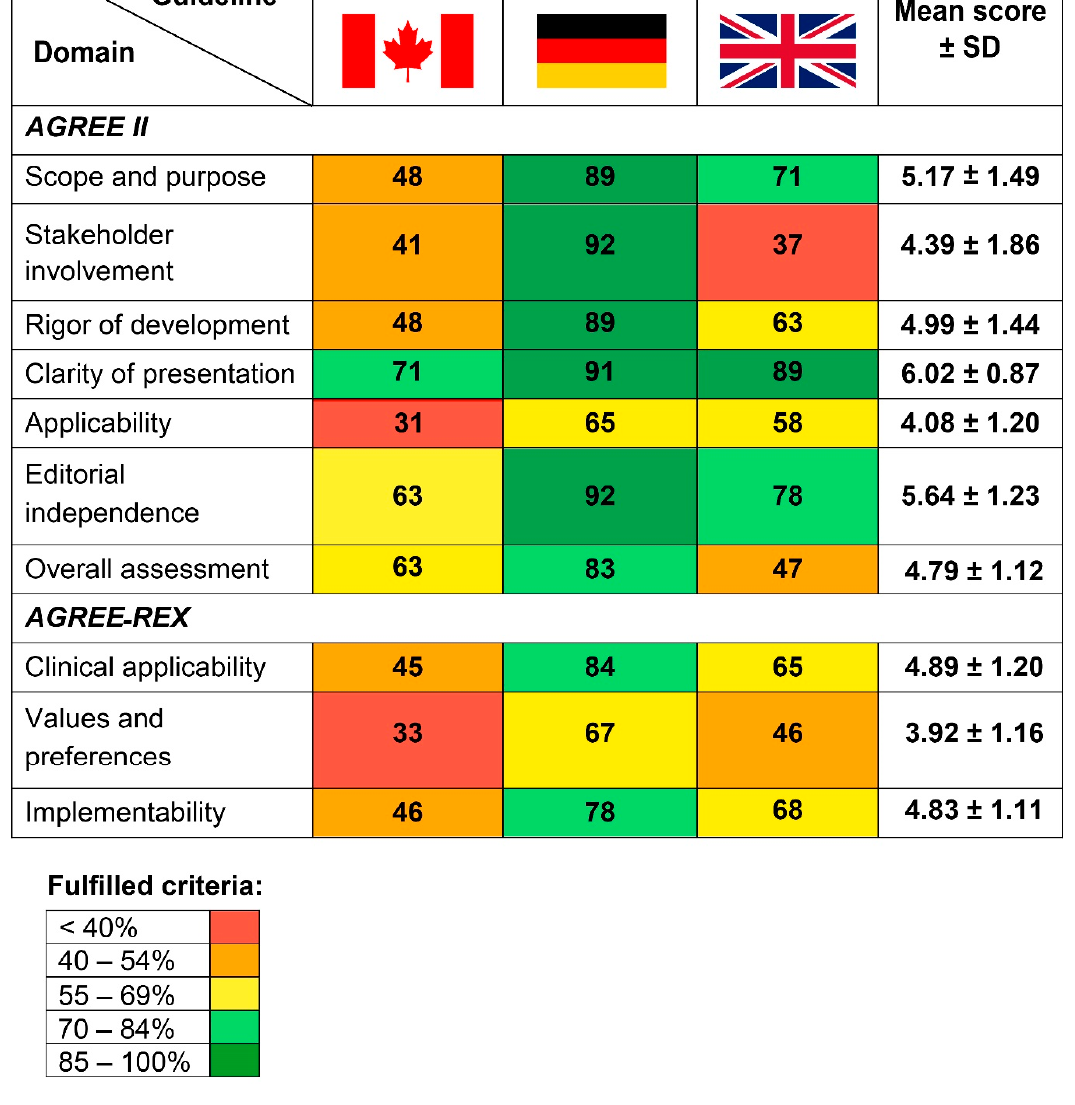
Figure 2. Heat map illustrating “Appraisal of Guidelines for Research and Evaluation” (AGREE II) and “Recommendation EXcellence” (AGREE-REX) scores of the three actinic keratoses (AK) guidelines evaluated by six independent reviewers.